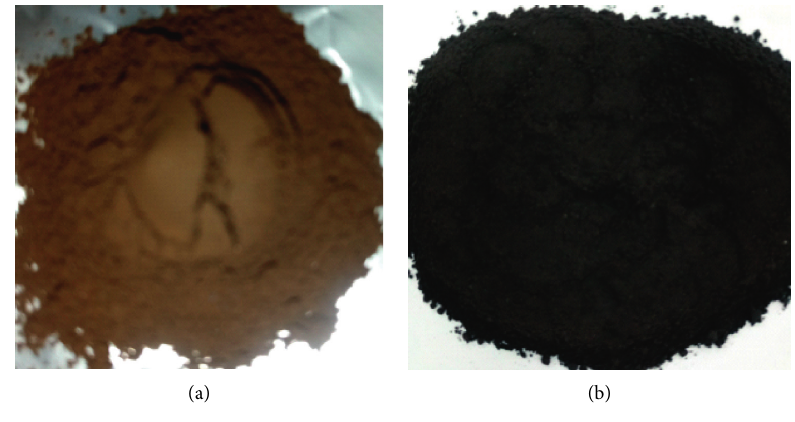
Figure 2: The powder of GO (a) and rGO (b).